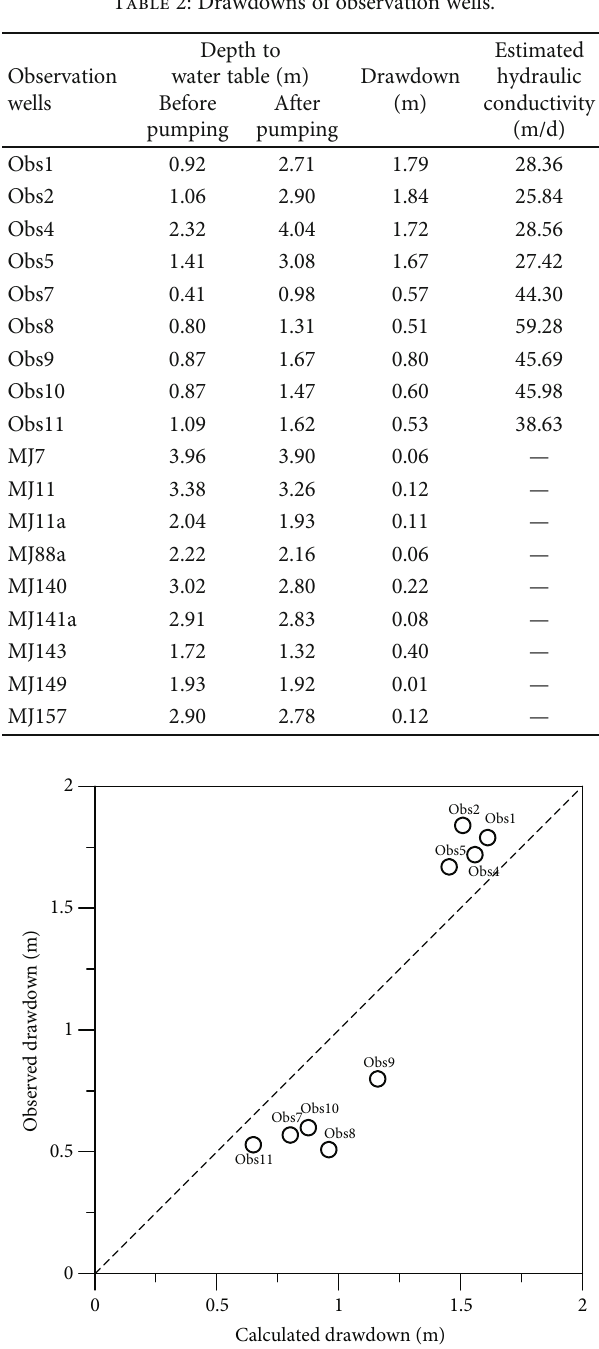
Figure 4: Observed versus calculated drawdowns of the observation wells with the best fi tting K value of